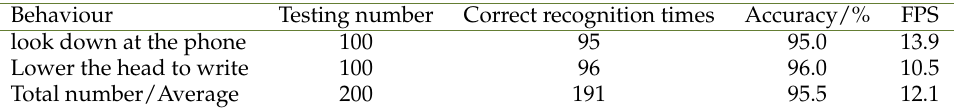
Table 3. Accuracy and efficiency